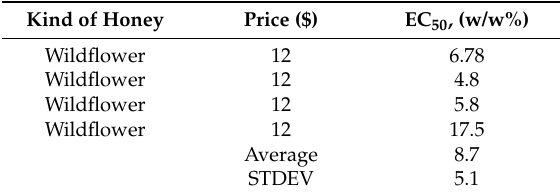
Table 5. Free radical scavenging values for the wildflower honeys (from different bottles that were purchased from the same vendor, [Israeli honey factory, termed above as vendor